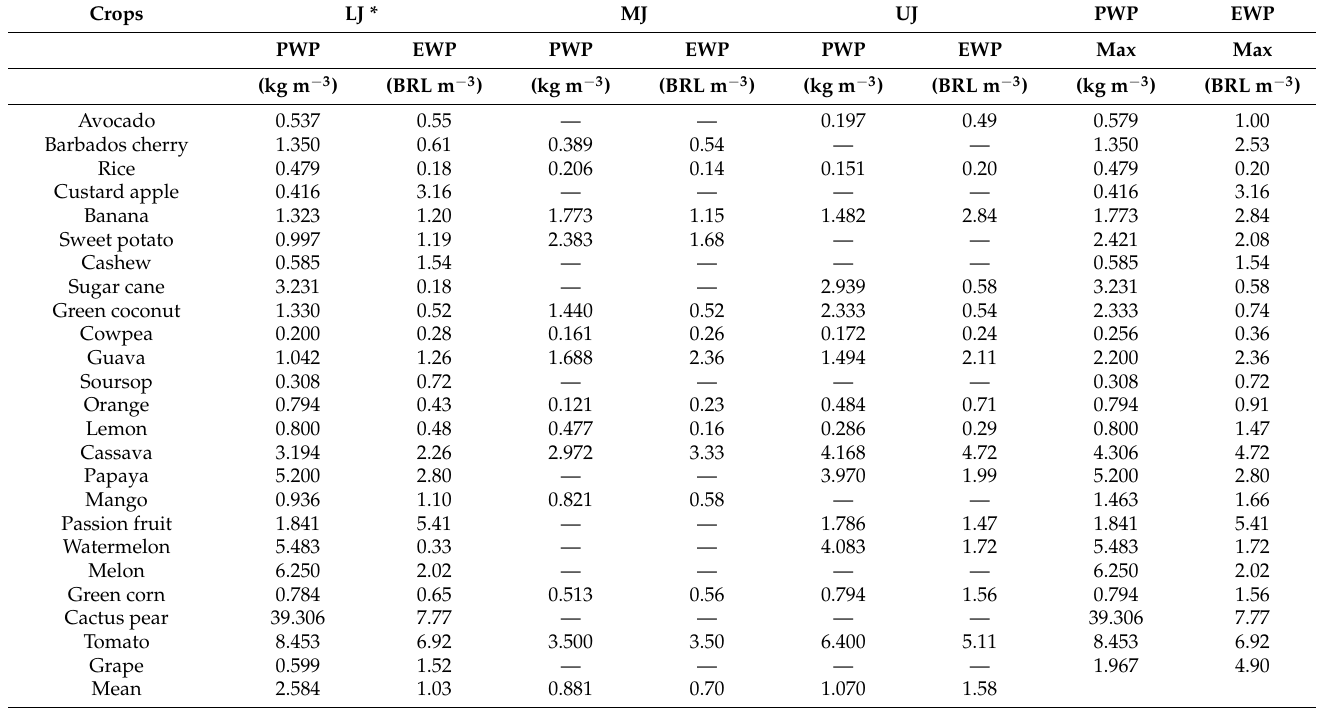
Table 5. Physical (PWP) and economic (EWP ) water productivity in the sub-basins of the Jaguaribe River. Crops